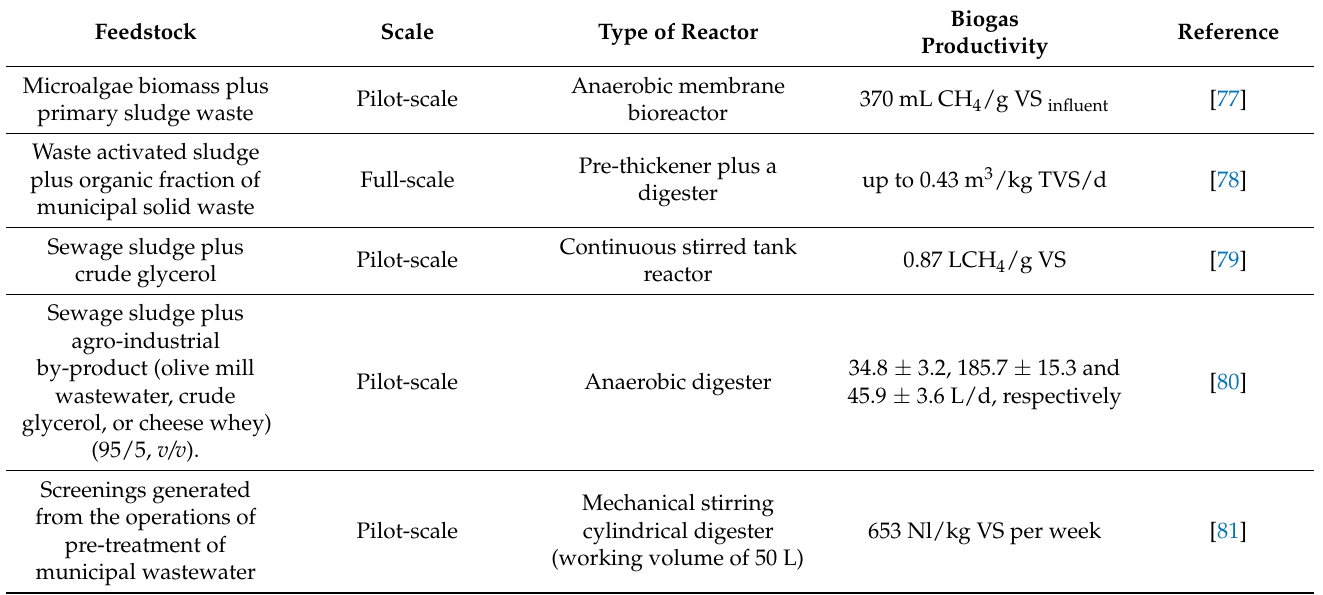
Table 7. Energy recovery as biogas in anaerobic digestion processes using different feedstocks.